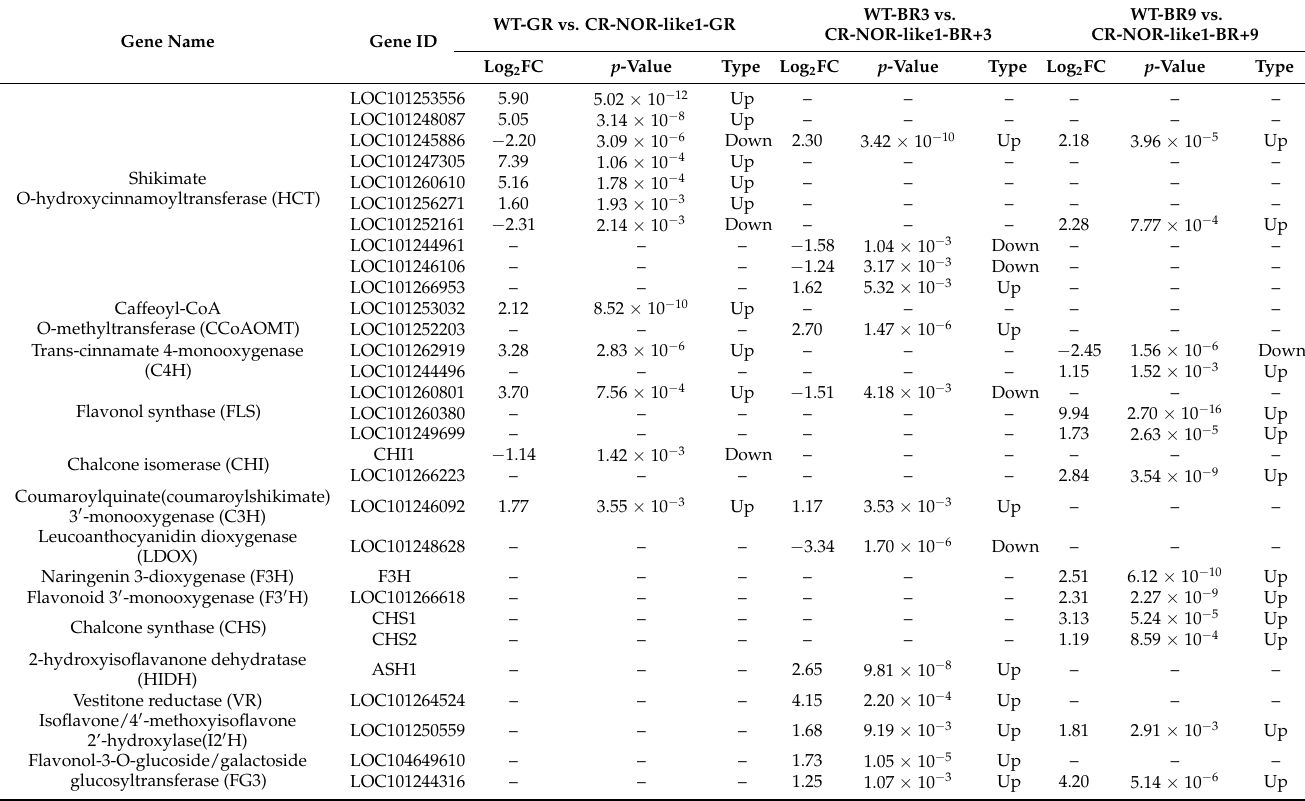
Table 3. List of DEGs related to